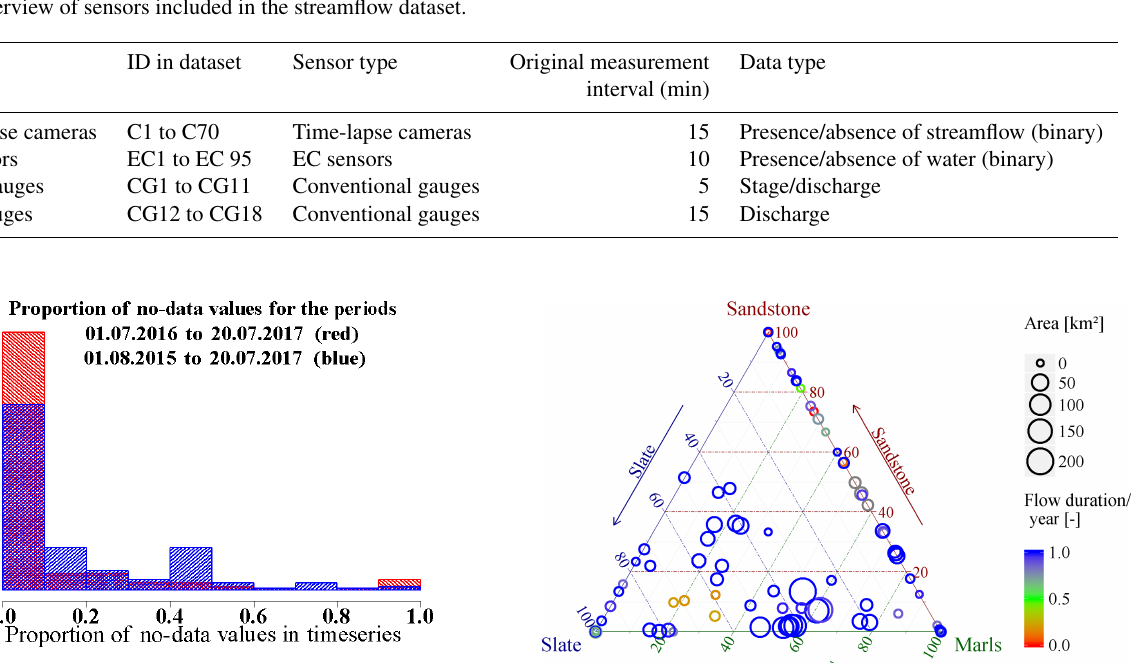
Figure 5. The proportion of no-data values in each time series is shown for all sites. The two selected periods, 1 July 2016– 20 July 2017 and 1 August 2015–20 July 2017, represent the best data availability with a more complete dataset for the shorter period with nearly 150 complete time series shown in red.